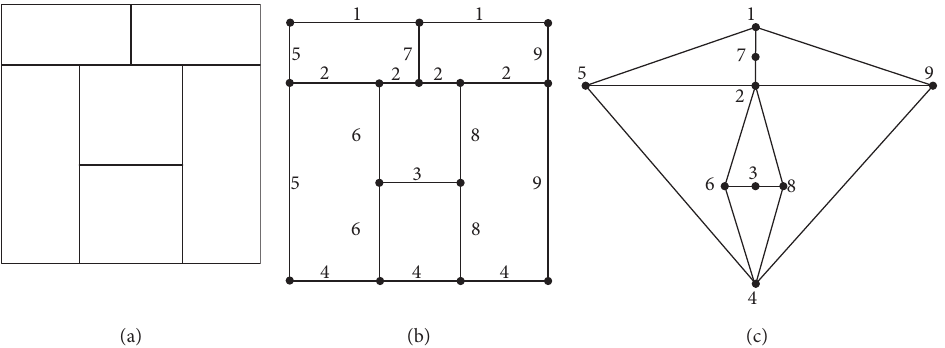
Figure 3: Diagram of a complex network of roads: (a) road network graph; (b) road network initialization graph; (c) road network dual